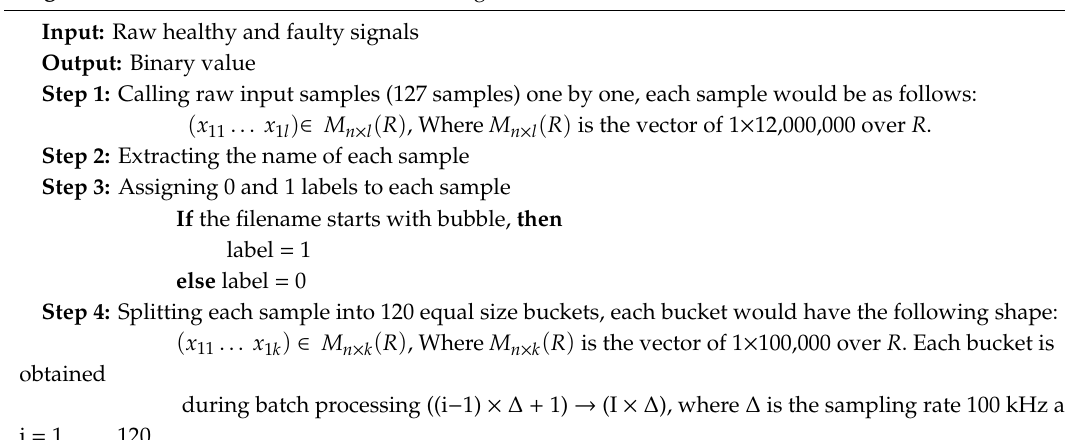
Algorithm 1 Pseudo-code of FFT_1D CNN